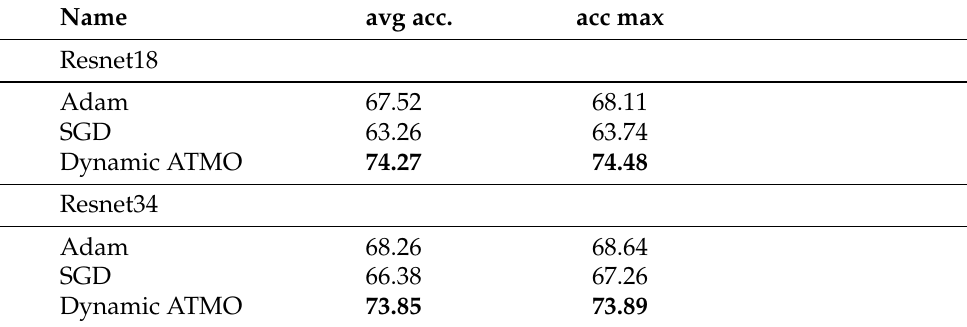
Table 3. Accuracy results on Cifar100, after 3 runs of 350